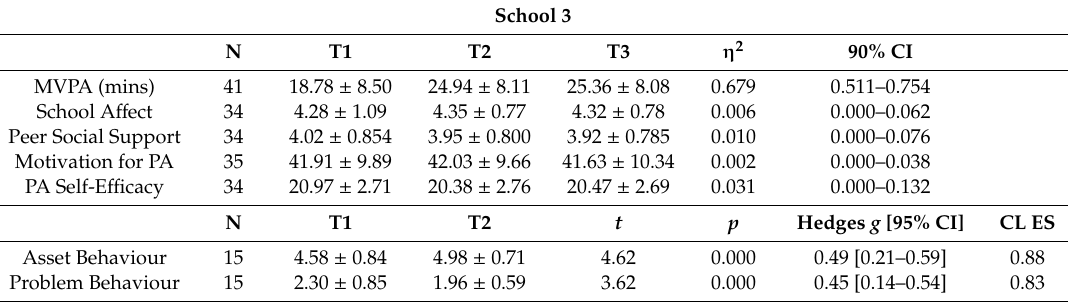
Table 6. School 3—mean scores and change over time for outcome